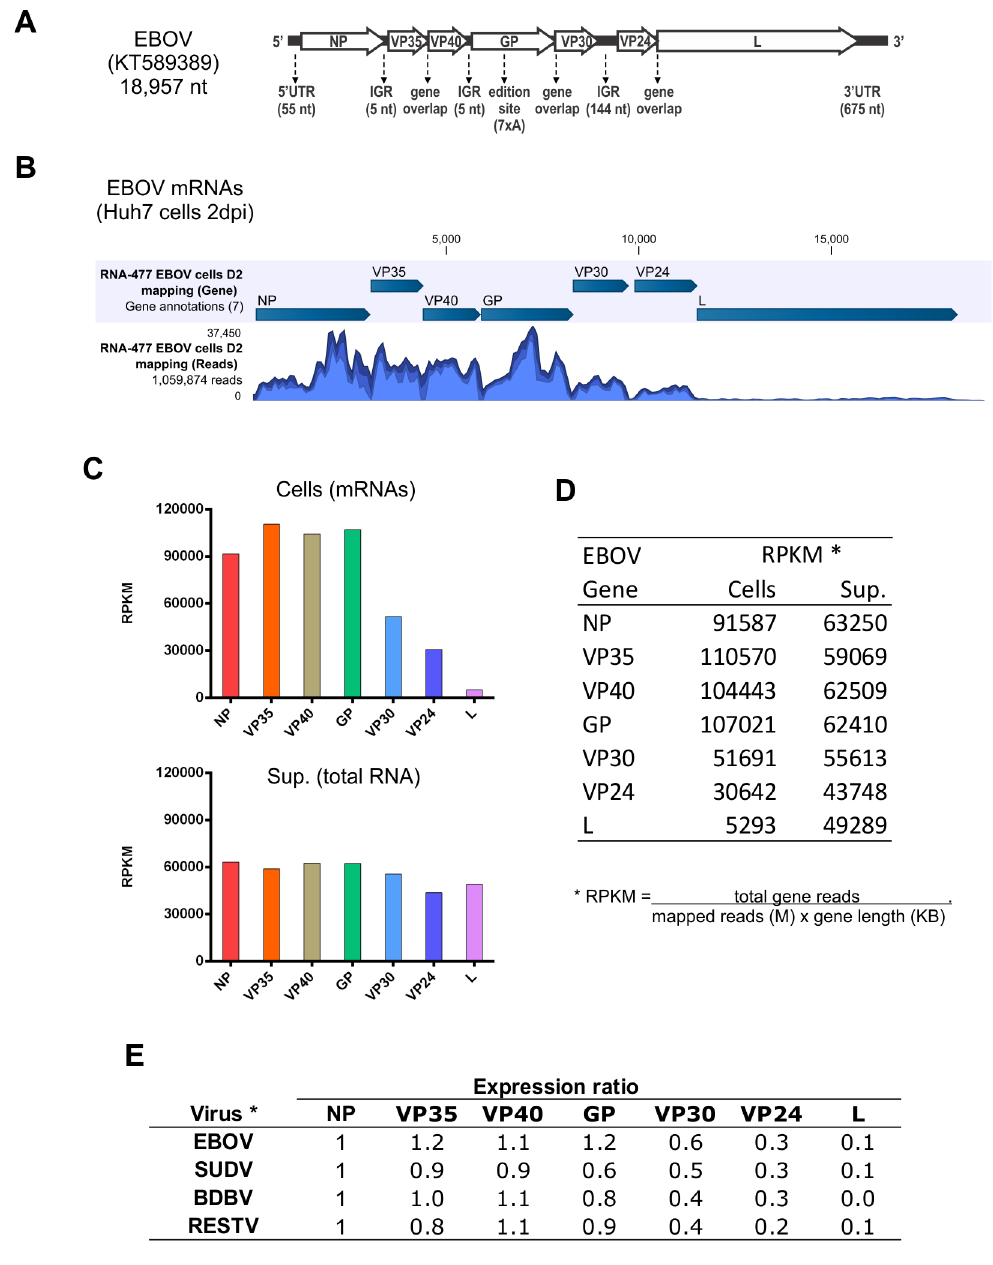
Fig 1. (A) Schematic representation of the genome of EBOV Makona variant (GenBank #KT589389), depicted in the viral complementary sense, with the seven genes shown in the 5 0 to 3 0 orientation. The lengths of the 5 0 and 3 0 untranslated regions (UTR), the intergenic regions (IGR), and the glycoprotein (GP) editing site are also indicated. (B) Graphical depiction of the mapped reads corresponding to EBOV mRNAs. Huh7 cells were infected with EBOV at moi = 0.1. Total RNA was harvested 2 days post infection, and purified mRNAs were used to make NGS libraries. (C and D) Graphical depiction and table showing the RPKM analysis of EBOV gene levels. The RPKM index standardizes the number of mapped reads to each gene, normalizing for gene length and for the total mapped reads of the library. “Cells” indicates mRNA isolated from cell lysates; “Sup.” refers to total RNA harvested from supernatants of infected cells. (E) Expression ratio of each viral gene relative to the nucleoprotein (NP) mRNA levels in Huh7 cells infected with EBOV, SUDV, BDBV, or RESTV.